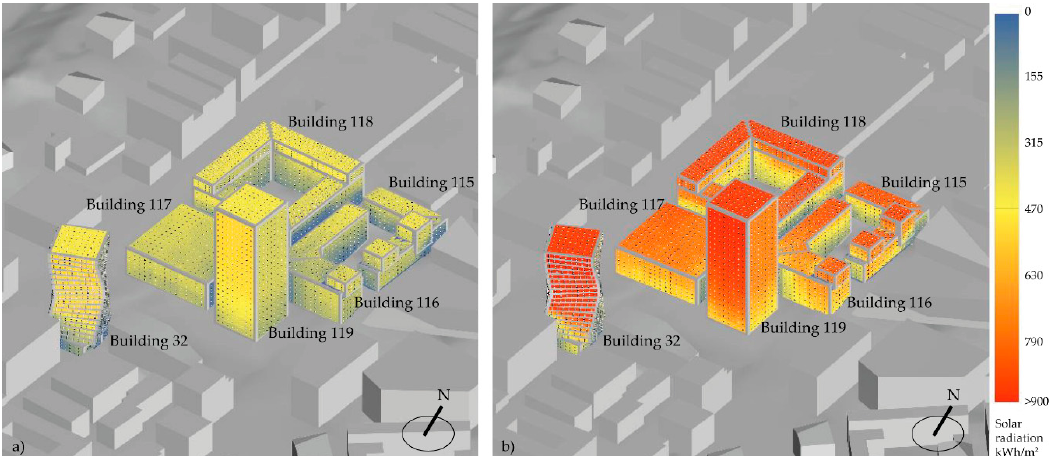
Figure 24. Analysis of direct solar irradiation ( a ) and global solar irradiation analysis ( b ) in the critical area for feasibility study II.